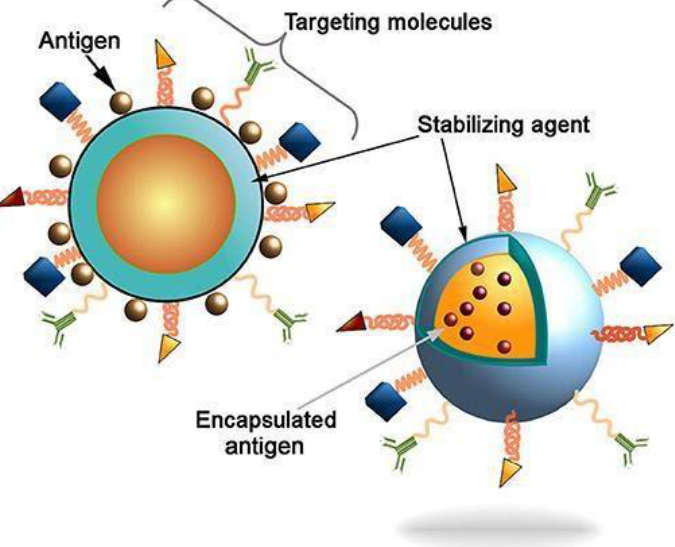
Figure 12. Schematic depiction of antigen delivery through nanocarriers with surface modification to enhance efficacy of vaccine against specific diseases. [207] Copyright © 2021 Pati, Shevtsov and Sonawane. This is an open-access article distributed under the terms of the Creative Commons Attribution License (CC